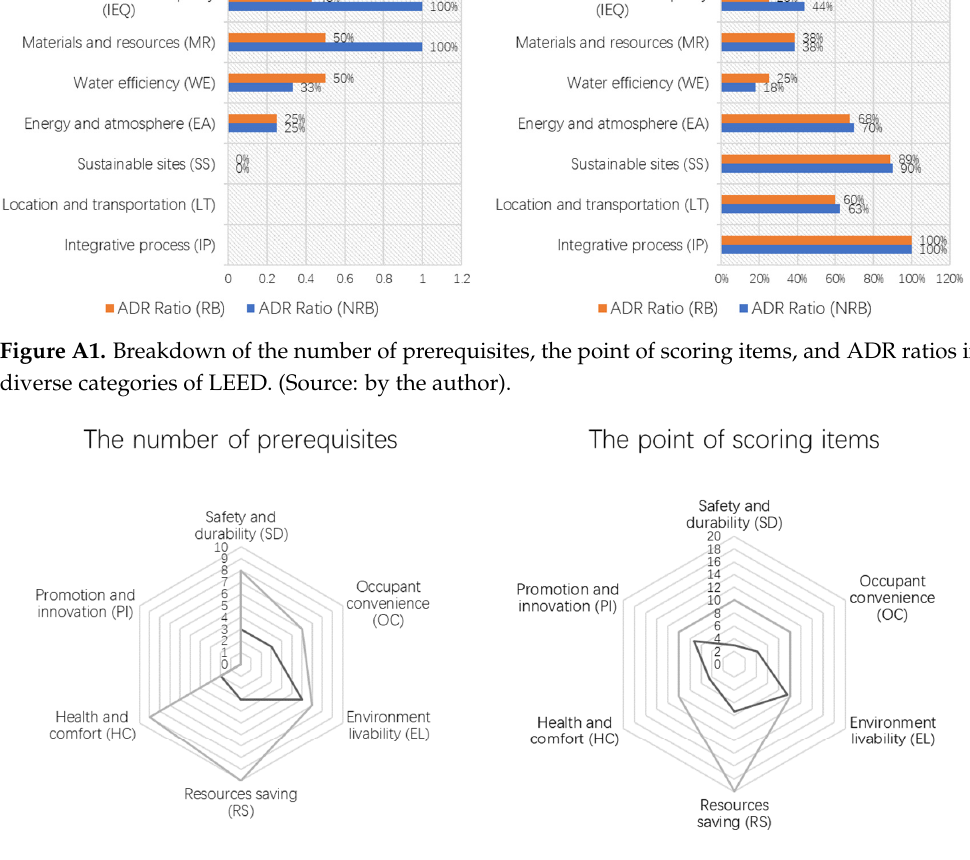
Figure A2. Breakdown of the number of prerequisites, the point of scoring items, and ADR ratios in diverse categories of ASGB. (Source: by the author)